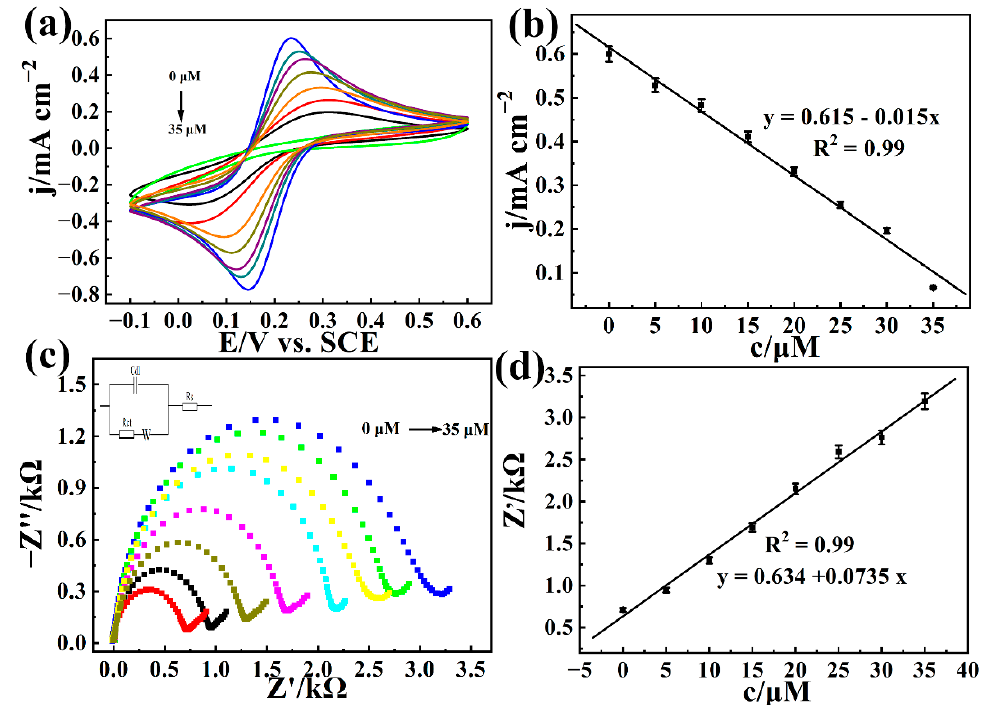
Figure 5. ( a ) CVs and ( c ) EIS (inset is its equivalent circuit) of AChE/COF DHNDA-BTH /GCE in 0.1 M KCl + 5.0 mM [Fe(CN)6] 3 − /4 − with different concentrations of carbaryl. ( b , d ) Corresponding linear relationship curves. Table 1. The comparison of AChE/COF DHNDA-BTH /GCE biosensor with other biosensors.